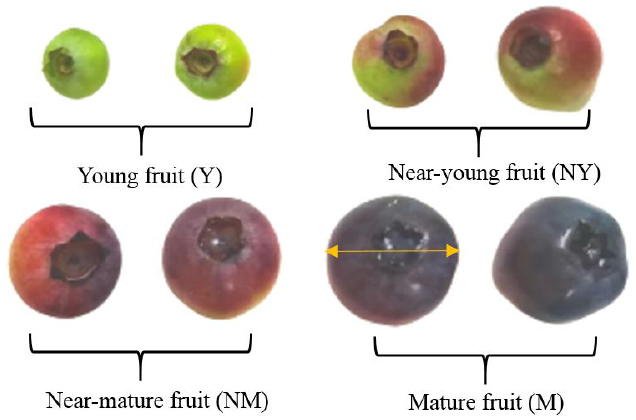
Figure 1. Blueberries that were used in the experimental